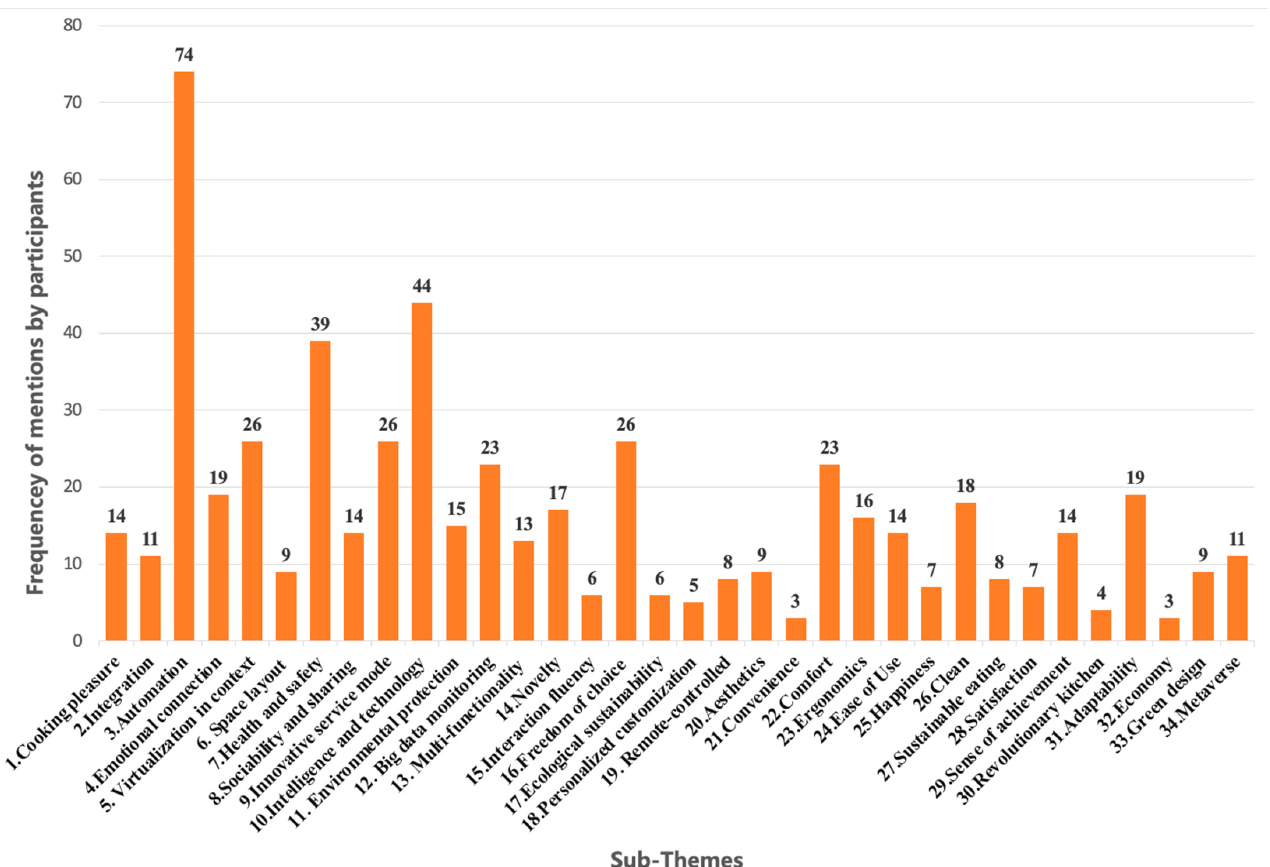
Figure 2. Distribution of sub-themes mentioned by participants (frequency).